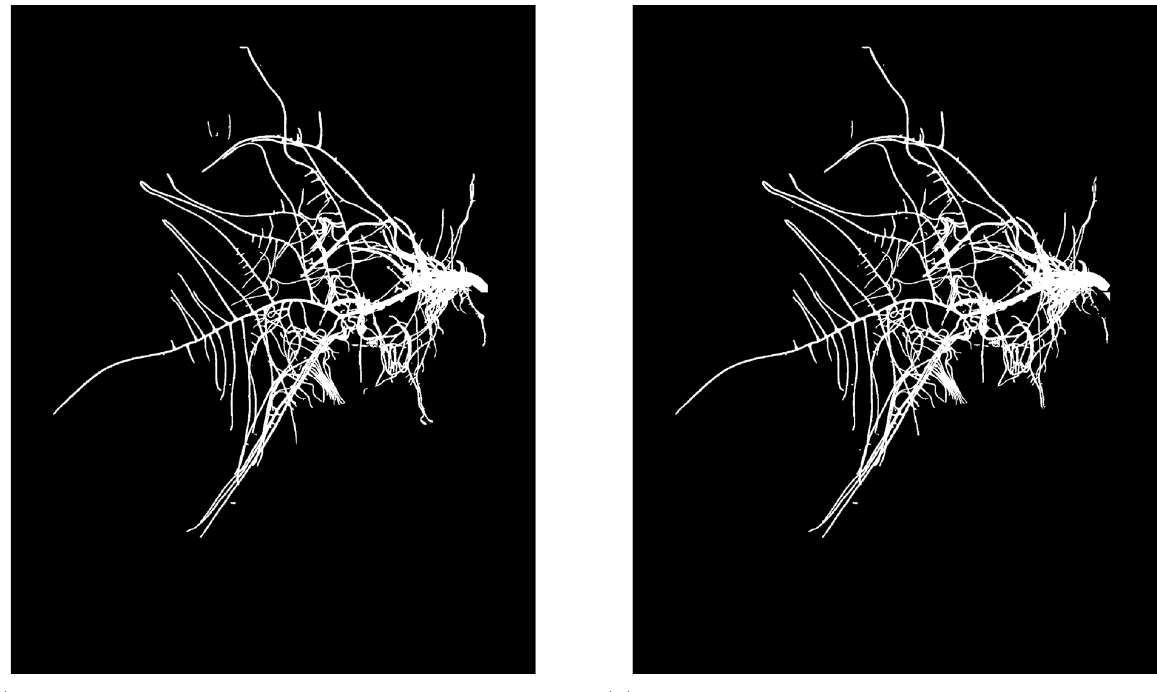
(b) The output on a cropped full image using the model from trial 2. from trial 1. Figure 12. Cropped image output examples from ( a ) the model trained in trial 1 and ( b ) the model trained in trial 2. We can see that when the non-root objects in the image are cropped away that both models give similar segmentations of the root system.